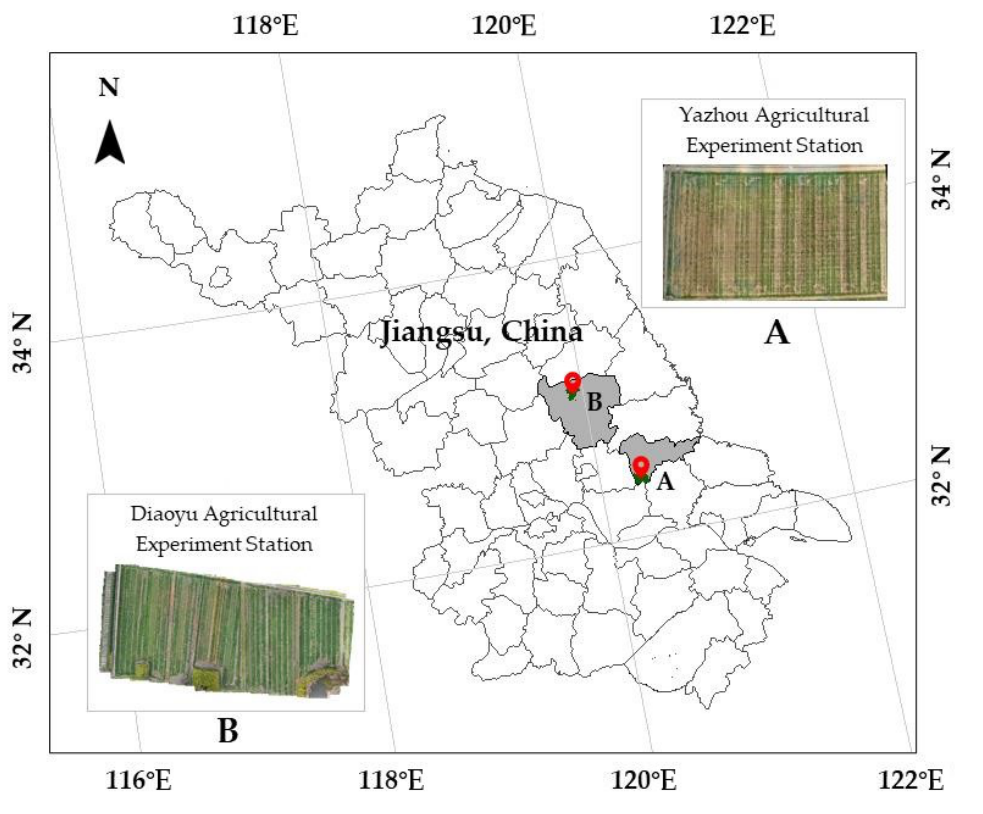
Figure 1. Overview of the study